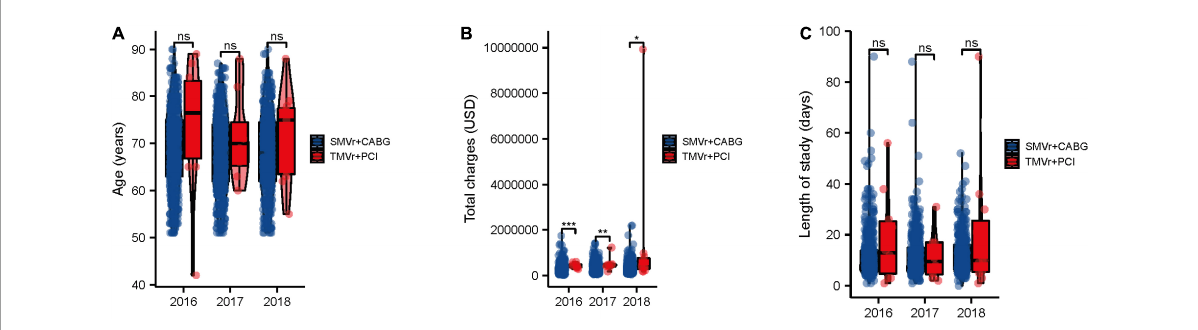
FIGURE2 Trends in SMVr + CABG and TMVr + PCI from 2016 to 2018. Trends in age (A) , cost of stay (B) , and length of stay (C) of patients undergoing SMVr + CABG and TMVr + PCI from 2016 to 2018 in the National Inpatient Sample (NIS) database. TMVr indicates transcatheter mitral valve repair; SMVR indicates surgical mitral valve repair; CABG indicates coronary artery bypass grafting; PCI indicates percutaneous coronary stent implantation. * P < 0.05, ** P < 0.01, *** P < 0.001.